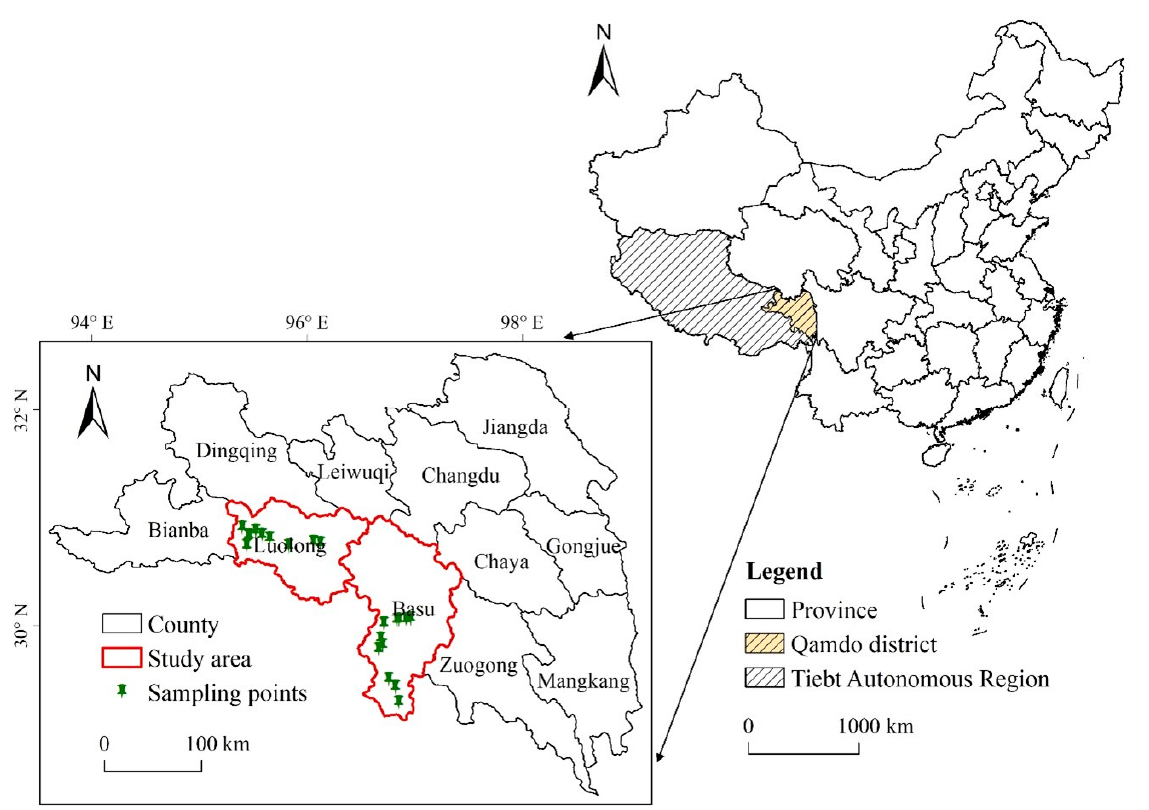
Figure 1. Location map for the study area and distribution of sampling sites.